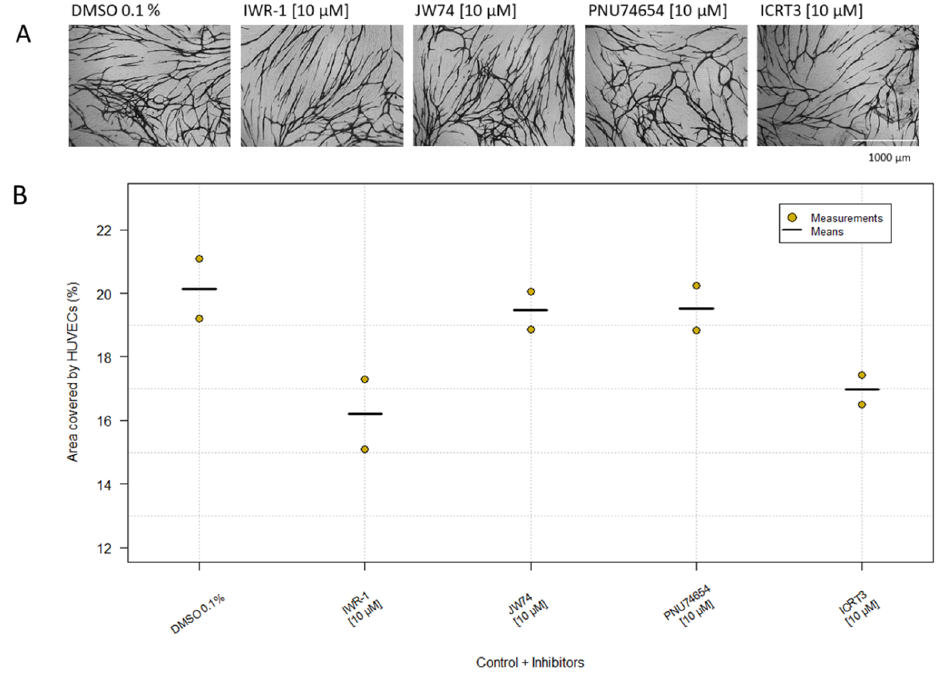
Figure 4. β -catenin inhibitors. DMSO 0.1% was used as control. Cells were treated with four different β -catenin inhibitors. ( A ) Morphology of the HUVECs was visualized by immunostaining with CD31 MAb in co-culture with NHDFs (magnification: 4×). ( B ) Data are shown in the plot as the mean of duplicates from two independent experiments compared with the control. Kruskal–Wallis X 2 = 6.98. P = 0.14.